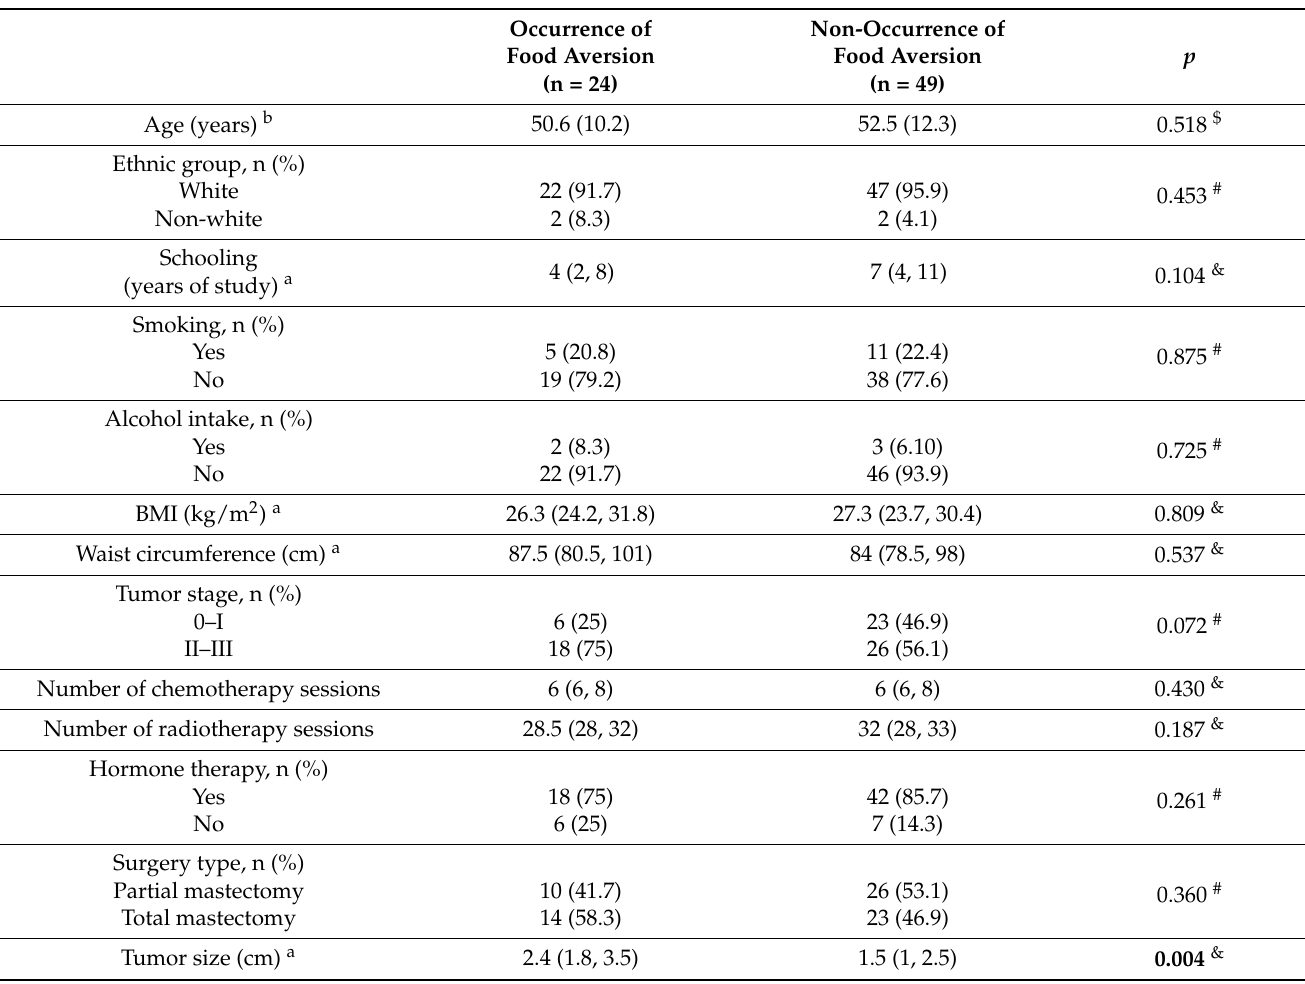
Table 1. Sociodemographic, clinical, anthropometric, and nutritional characteristics of women with breast cancer, according to food aversion occurrence during adjuvant chemotherapy (n = 73). Non-Occurrence of Occurrence of p Food Aversion Food Aversion (n = 49) (n = 24) 50.6 (10.2) 52.5 (12.3) 0.518 $